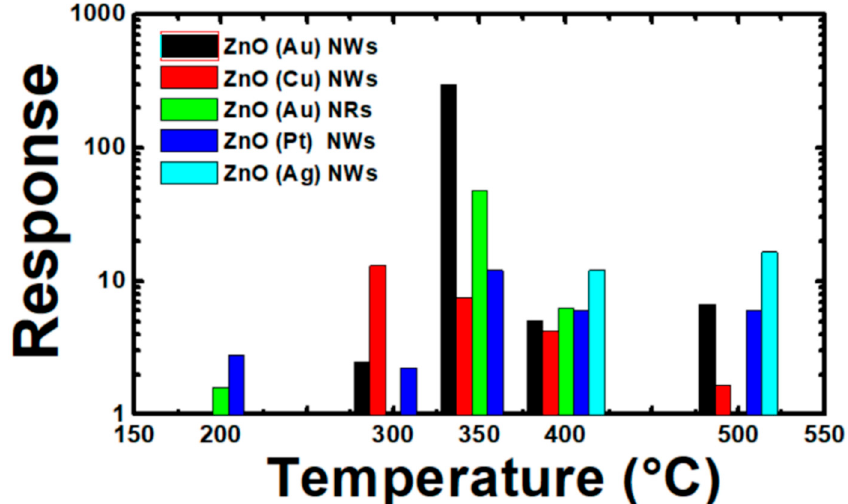
Figure 8. Sensors response under hydrogen injection (500 ppm) of 1D ZnO nanostructures using different catalysts as a function of temperature. The relative humidity was 50%.